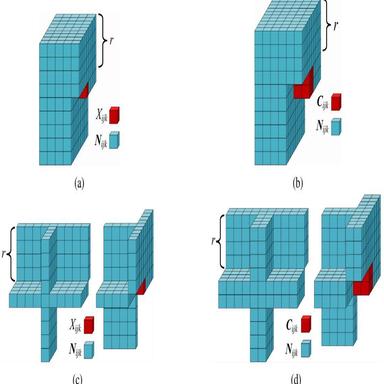
The 3D training images of three microstructures with different morphological features.